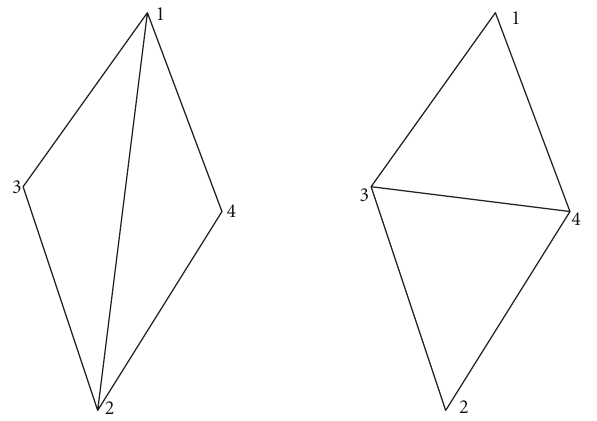
Figure 4: Two-dimensional edge swapping.